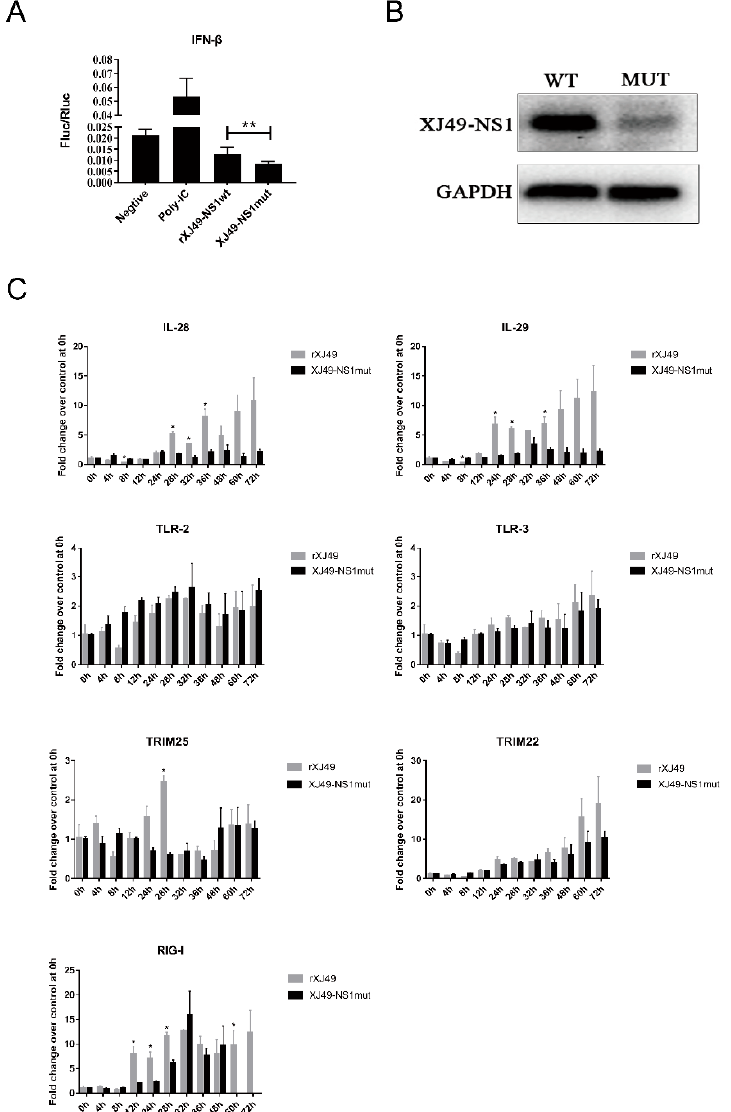
Figure 4. The H1N1 NS1 protein with the dual R108K/G189D mutation impairs host innate immune responses. ( A ) Ability of the mutant influenza NS1 protein to inhibit IFN- β promoter activation. Human 293T cells were transiently co-transfected with a reporter plasmid encoding FF–Luc under the control of the IFN promoter (p125-luc), a plasmid constitutively expressing Rluc under the control of the HSV–TK promoter (pRL), and the WT or mutant NS1 pW2000 expressing plasmids. Empty pHW2000 plasmid was used as a negative control, while poly (I:C) was used as a positive control (**, p < 0.001). ( B ) NS1 protein expression in transfected cells was evaluated by Western blotting with an antibody specific for the viral NS1 protein. GAPDH was used as a loading control. ( C ) Expression of cytokine mRNA in infected A549 cells. A549 cells were infected with rXJ49 and XJ49-NS1mut at a MOI of 5. The cells were collected at 0 h, 4 h, 12 h, 24 h, 28 h, 32 h, 36 h, 48 h, 60 h, and 72 h, and cytokine gene expression was quantified by qRT-PCR (*, p < 0.001).